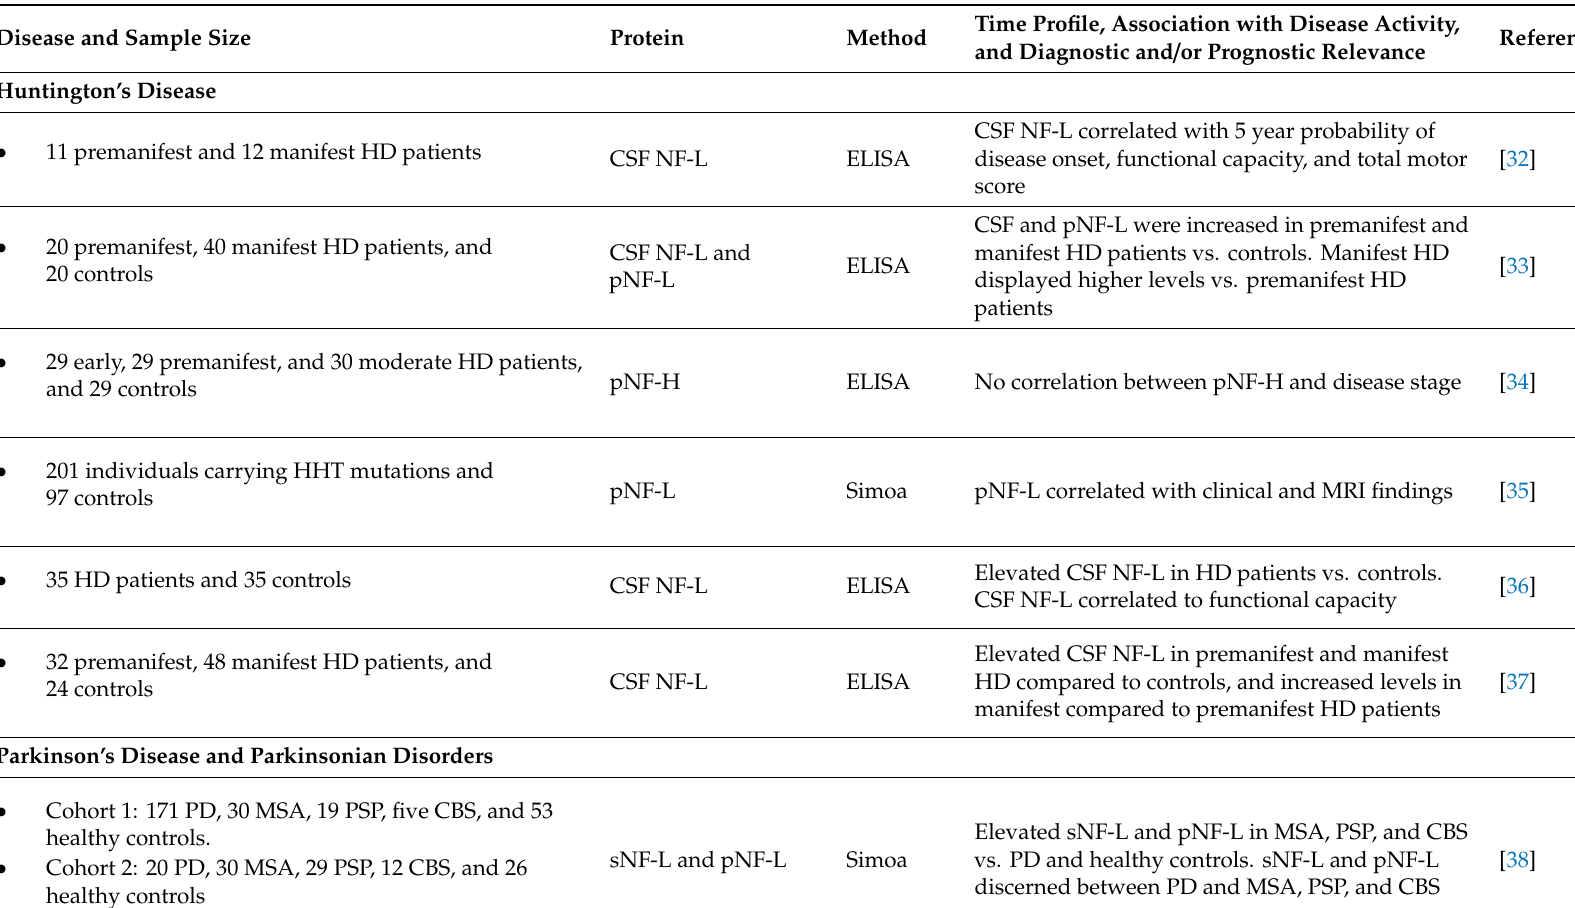
Disease and Sample Size Protein Method